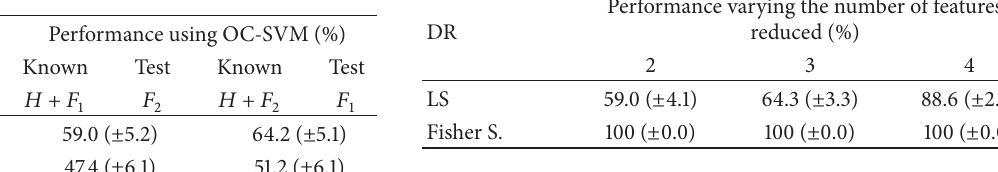
Table 2: Performance of the novelty detection employing a reduc- tion of features during retraining. Different scenarios are included according to the information available to train and test the novelty model.